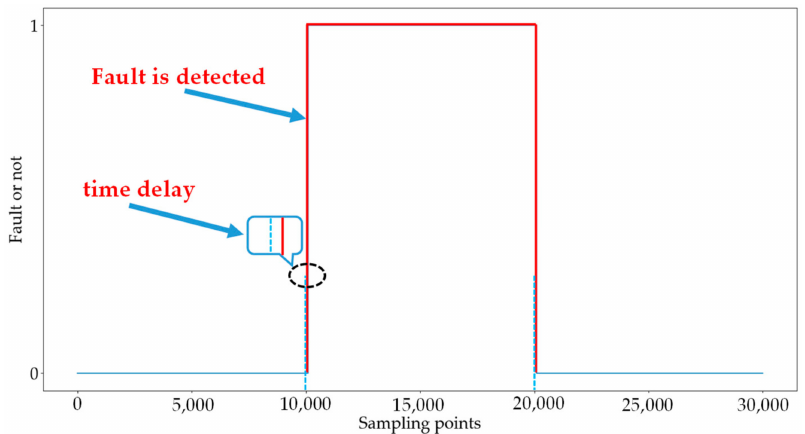
Figure 7. The fault is detected by the proposed model.